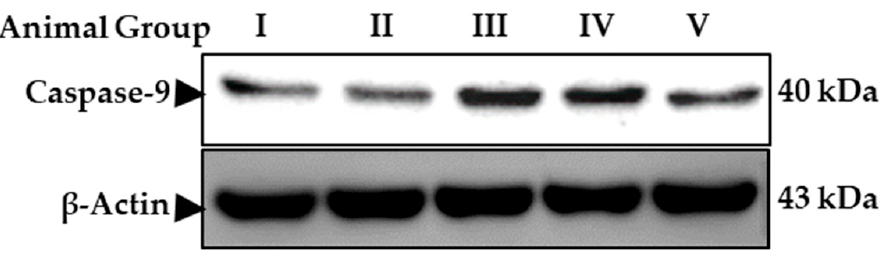
Figure 3. Western blotting of breast nude mice tumors collected in April 2018 using antibodies against caspase-9. Groups I–V.